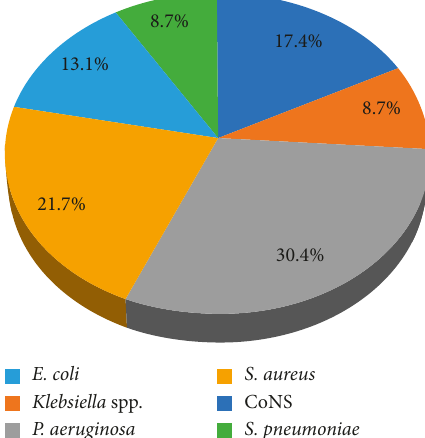
Figure 1: Multidrug resistant bacteria isolated from NI-suspected patients at Hiwot Fana Specialized University Hospital, Eastern Ethiopia, March 2017 to July 2017.